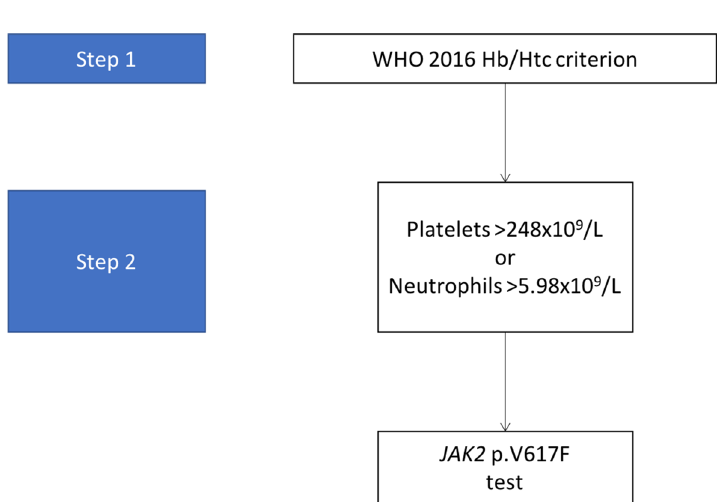
Figure 2. The “two-step” algorithm. This figure shows the algorithm based on data obtained in Step